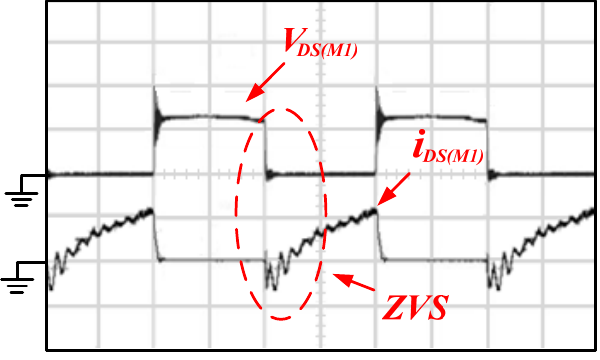
Figure 16. Measured voltage and current waveforms of switch M : 2 A/div; time : 5 s/div). i DS